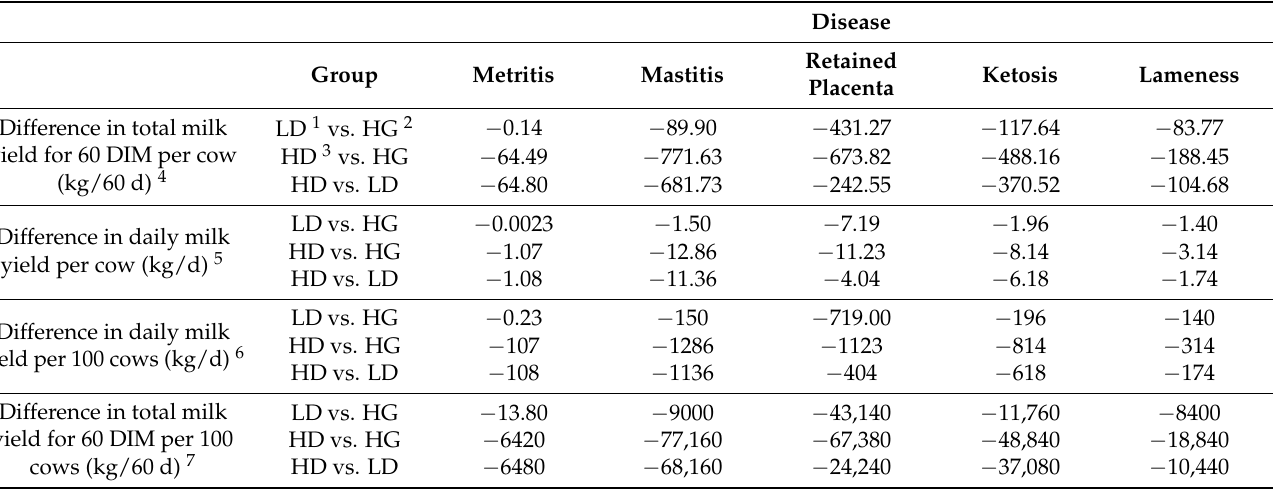
Table 7. Milk yield differences between groups for each disease for daily yield and total yield for 60 DIM per cow and for 100